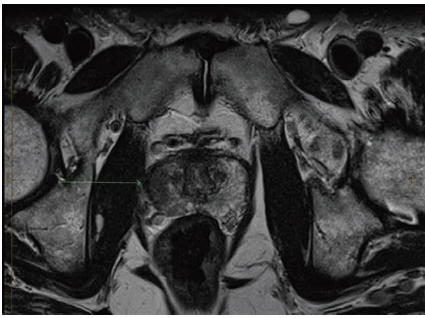
Figure 1: MRI image of prostate in patients with prostate cancer.